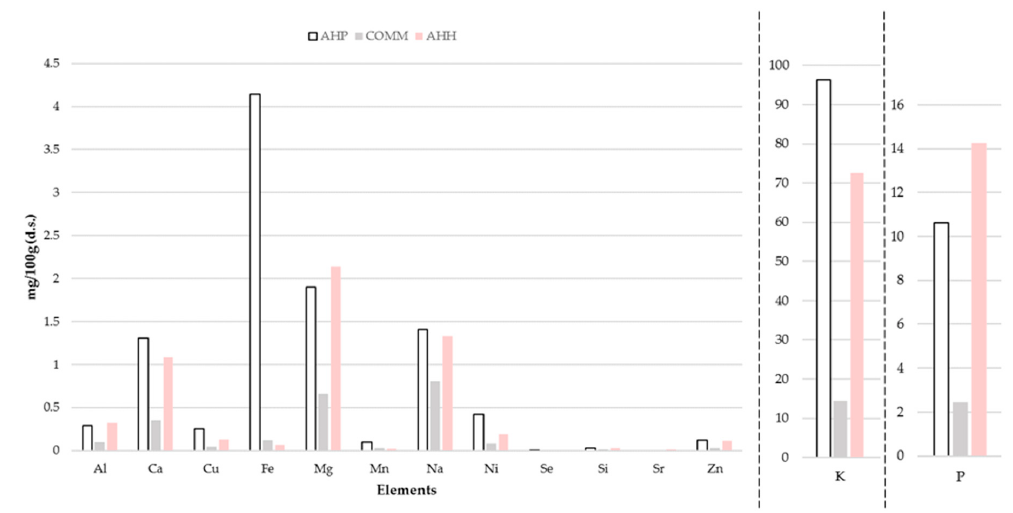
Figure 4. Distribution histograms for each element obtained on AHP, AHH, and COMM tincture samples.